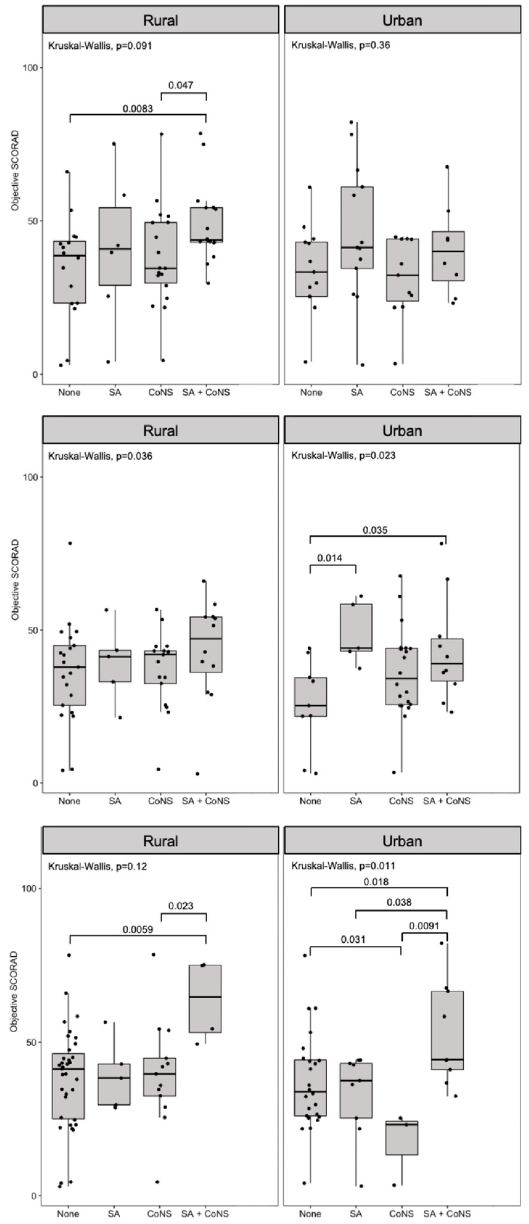
Staphylococcus aureus ; CoNS, coagulase-negative Staphylococcus ; SA + CoNS, simultaneous colonization with S . aureus and